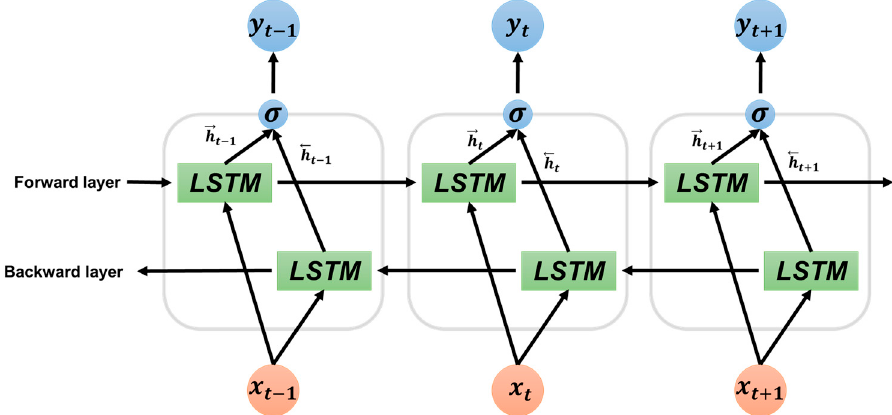
Figure 6. Structure and description of bidirectional LSTM used to improve model performance.